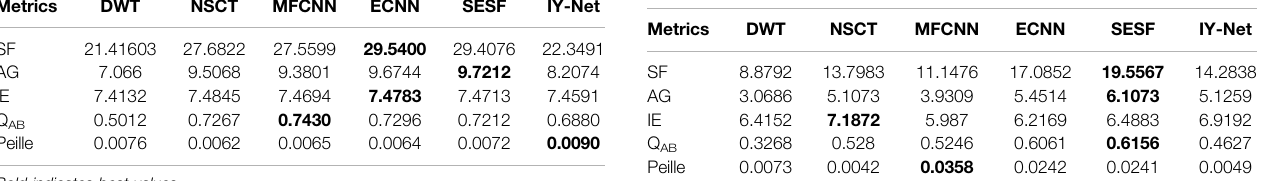
TABLE 1 | Quantitative evaluation results of multi-focus image fusion. TABLE 3 | Quantitative evaluation results of infrared intensity and polarization image fusion.